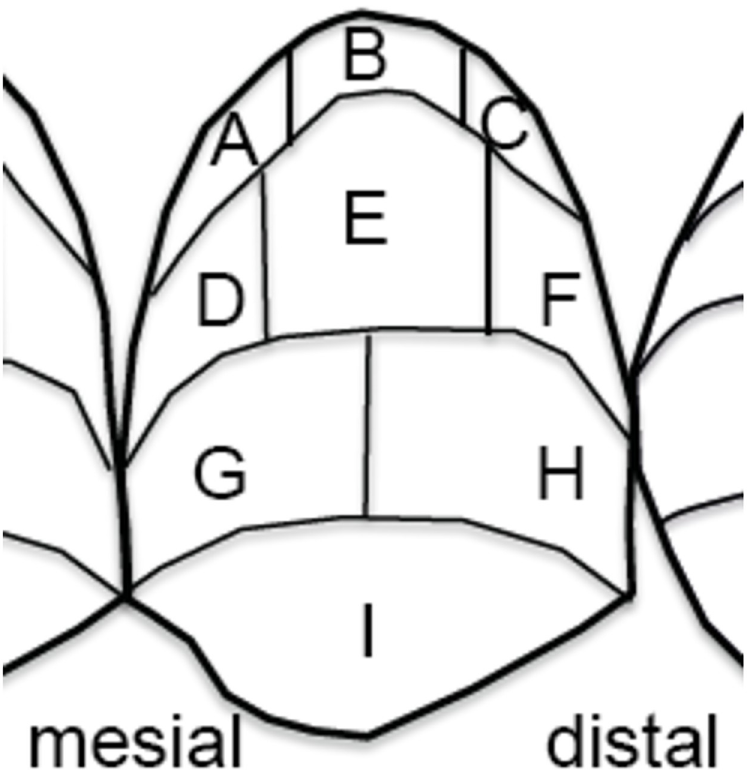
Fig 2. Areas of the Rustogi modified Navy-Plaque-Index (RMNPI). A and D represent the mesial proximal areas, C and F the distal proximal areas.